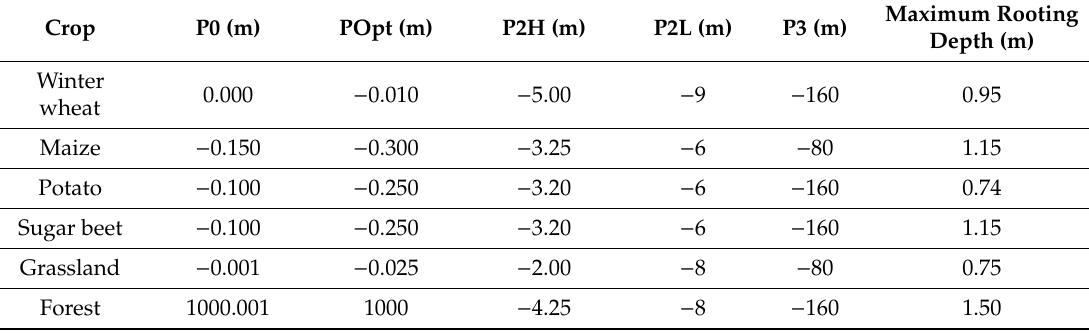
Table 2. The Feddes stress response function parameters and maximum rooting depths of di ff